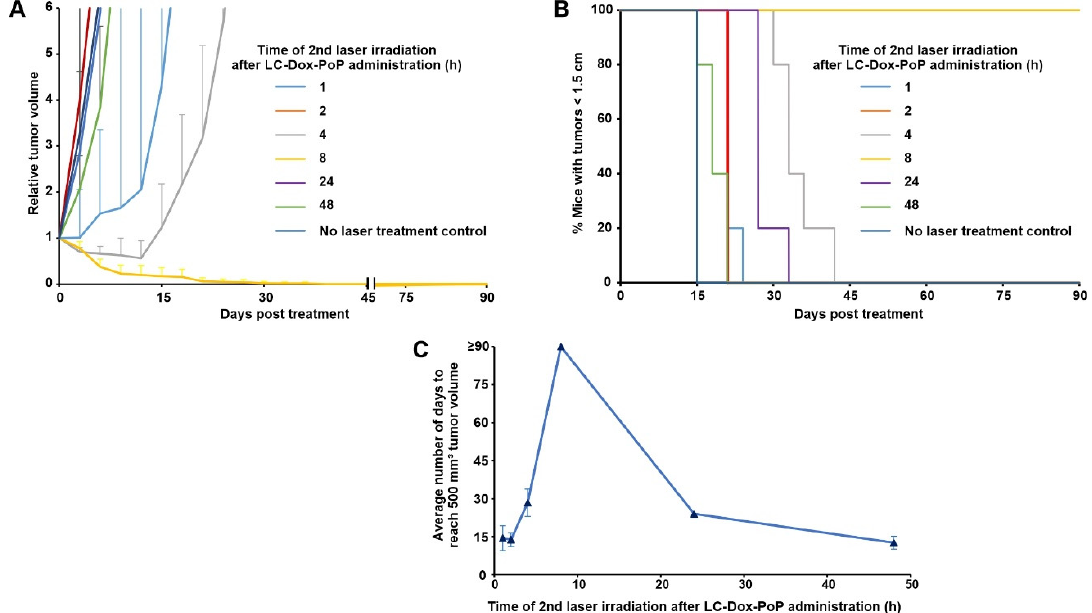
Figure 4. Timing of a second laser treatment on CPT efficacy. Mice bearing MIA PaCa-2 xenografts were intravenously injected with 3 mg/kg LC-Dox-PoP liposomes and treated with a 1 h DLI with an initial 665 nm laser treatment of 150 J/cm 2 at a 150 mW/cm 2 fluence rate. At the indicated times, a second laser treatment of 50 J/cm 2 was administered. Mice were sacrificed when the tumors grew to 1.5 cm in size. ( A ) Relative tumor growth. ( B ) Percentage of mice with tumor sizes less than 1.5 cm. ( C ) Average time taken for tumors to grow 500 mm 3 for mice treated with the indicated timing of the second laser treatment. Data show mean ± std. dev. for n = 5 mice per group.